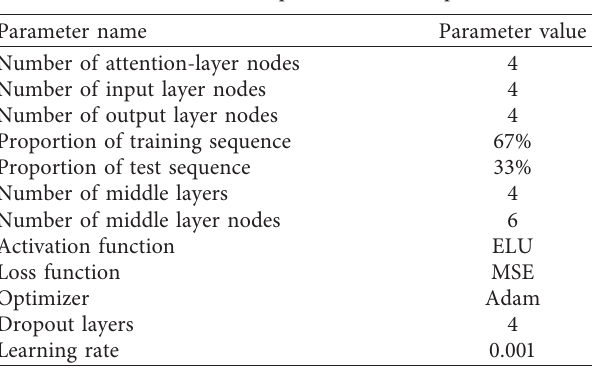
Table 5: Attention-LSTM prediction model parameters.